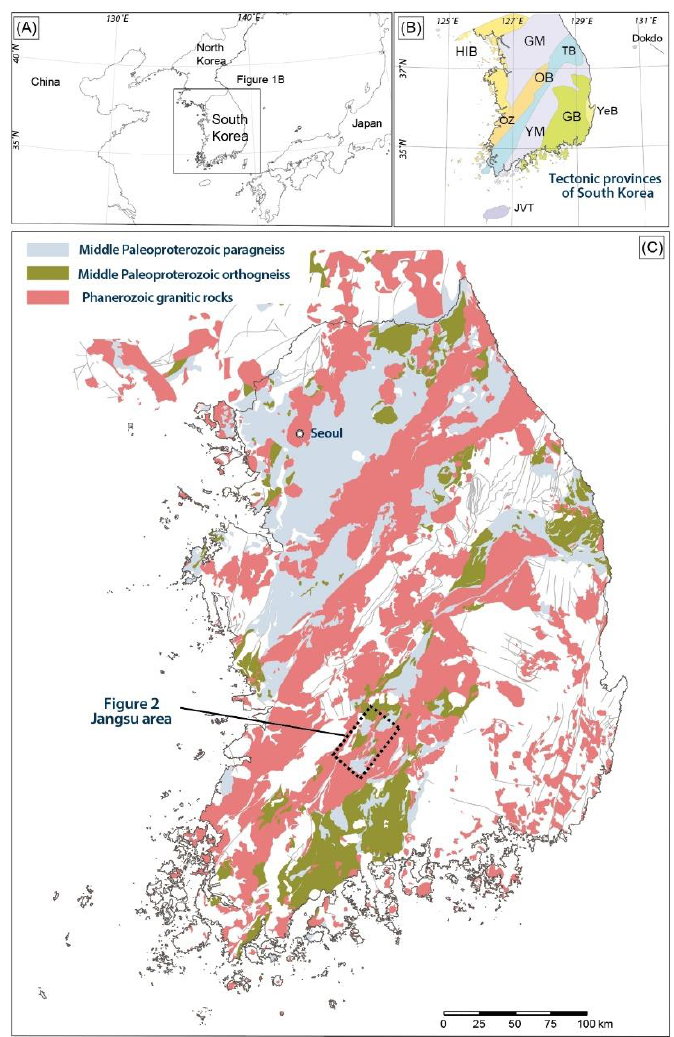
Figure 1. (A ) Location map in the East Asian countries including South Korea, ( B ) tectonic map of South Korea, and ( C ) geological map of South Korea showing the distribution of the Middle Paleo- proterozoic gneisses and Phanerozoic granitic rocks. HIB, Hongseong – Imjingang belt; GM, Gyeonggi massif; OB, Okcheon belt; YM, Yeongnam massif; GB, Gyeongsang basin; YeB, Yeonil basin; JVT, Jeju volcanic